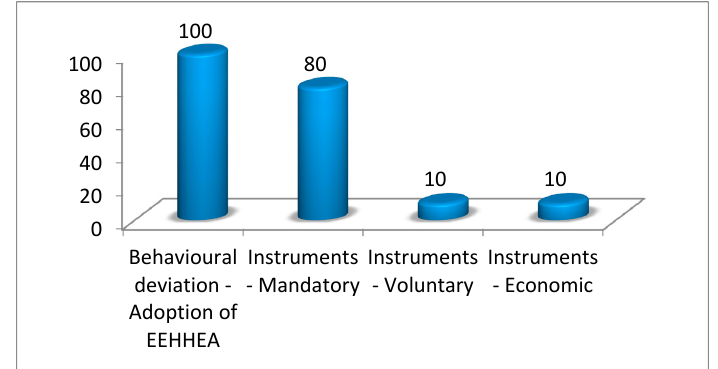
Figure 12. Implied behavioral deviation of the target group from current practices and the strength of instruments required for enforcement according to the experts interviewed.